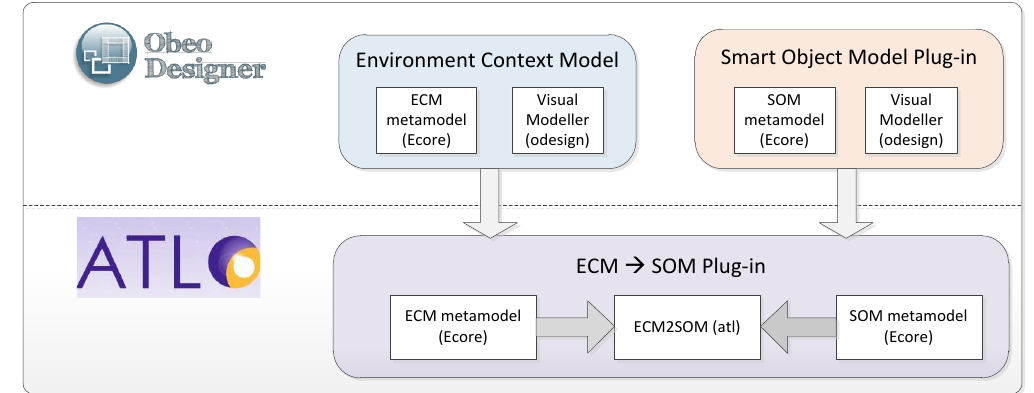
Figure 17. Eclipse plug-ins used for developing the ECM and SOM metamodels and their corresponding mapping to transform ECM into